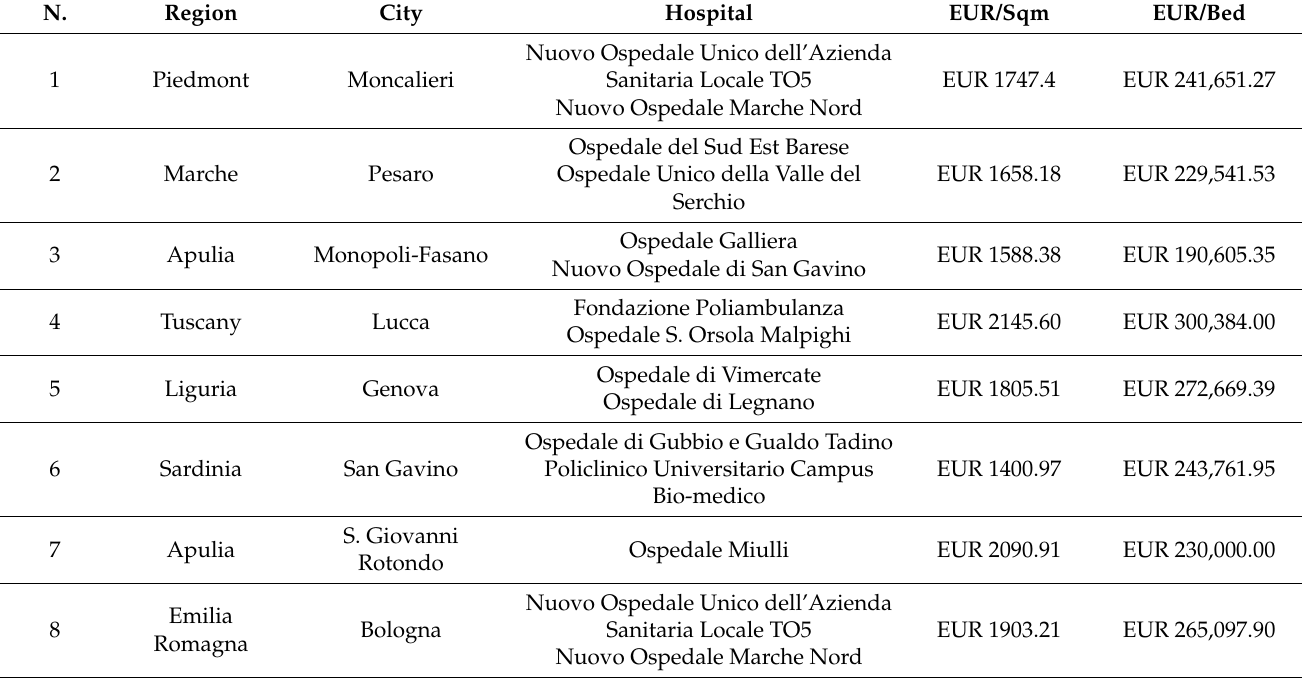
Table 3. Case studies’ construction cost per square meter and